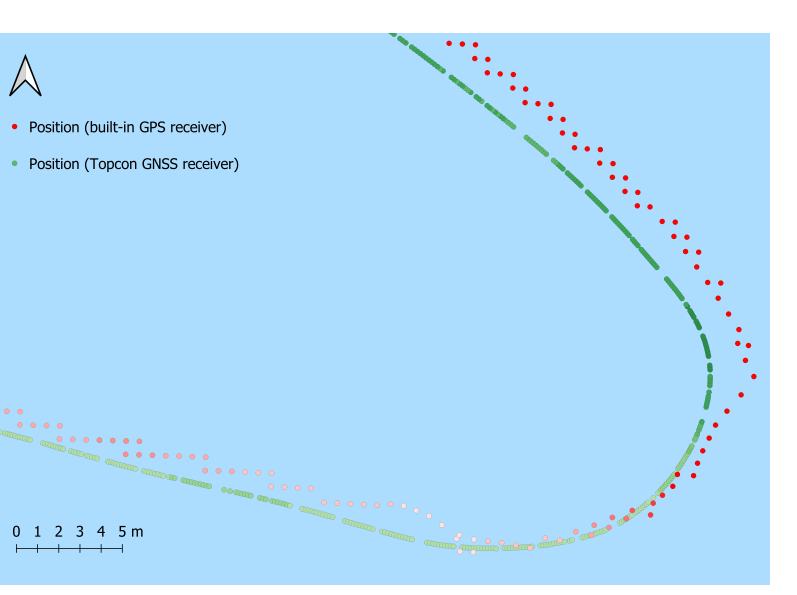
Figure 1. Correction of the survey (red dots) points’ geographical location, obtained from the instrument GPS receiver, using the Topcon GNSS (green dots).